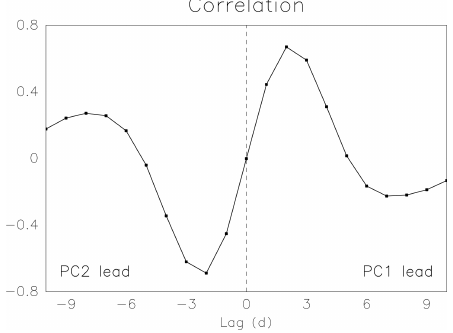
Figure 8. Lag correlation in the unit of day between the principle component corresponding to the first and second EOF modes.